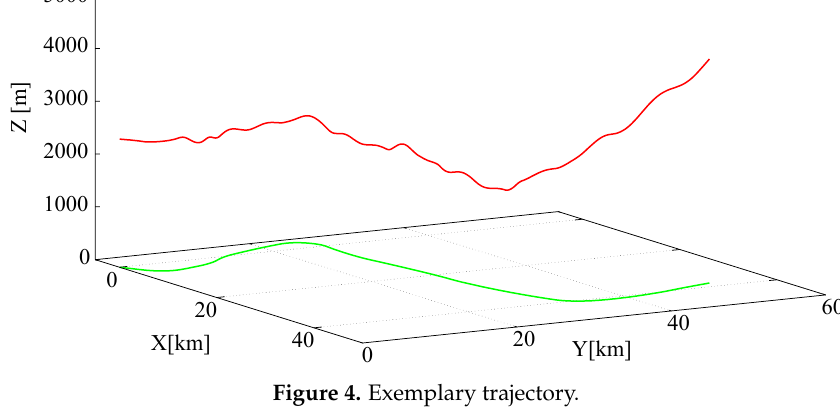
Figure 4. Exemplary